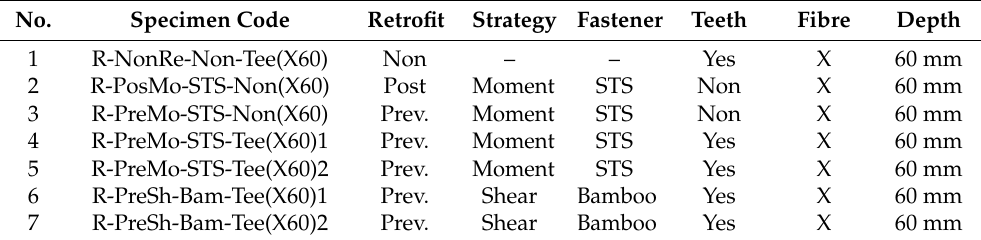
Table 2. Specimens of rotational